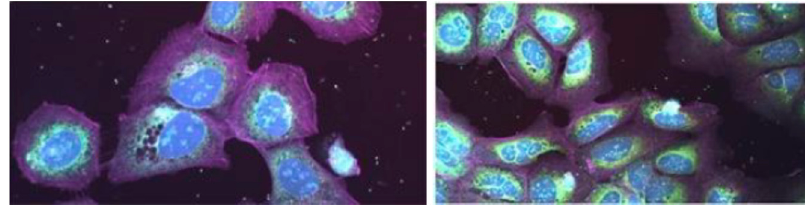
Figure 9. Comparison of situation photo images for each cell of new drug candidates [80].